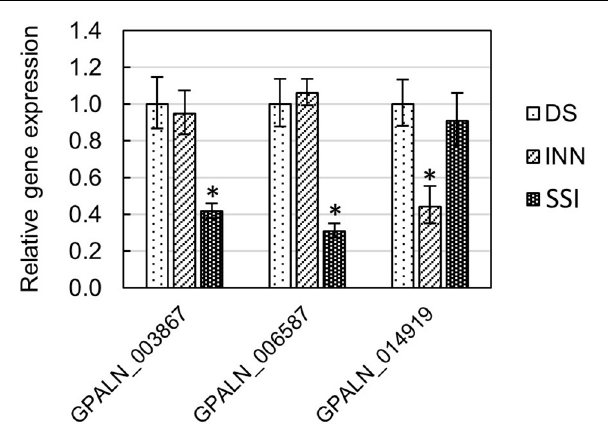
FIGURE 7 | Relative gene expression of selected Globodera pallida DEGs (GPALN_003867, GPALN_006587, and GPALN_014919) was measured using the qRT-PCR method. Three different hatching conditions were tested: DS – susceptible potato variety cv. Desirée, SSI – immune plant S. sisymbriifolium , and INN – resistant potato variety cv. Innovator. The Gp EF1 α gene (GPALN_011311) was used as an internal reference gene. Error bars are the mean ± SE, n = 3 biological replicates. Asterisk mark represents significantly different results as determined using ANOVA followed by Tukey’s HSD test at p < 0.05. See Supplementary Table 2 for primers